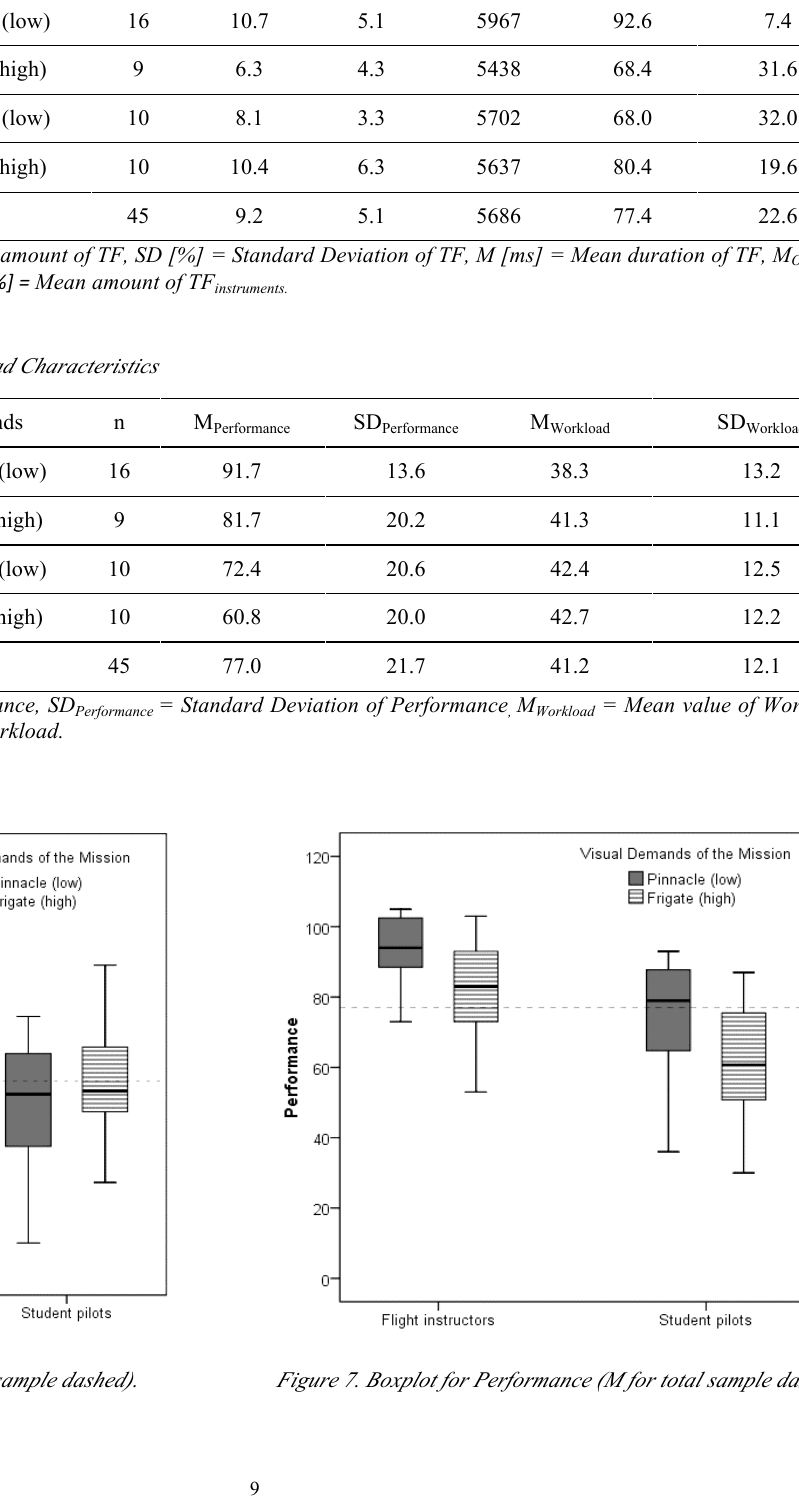
Descriptive TF Characteristics Experience